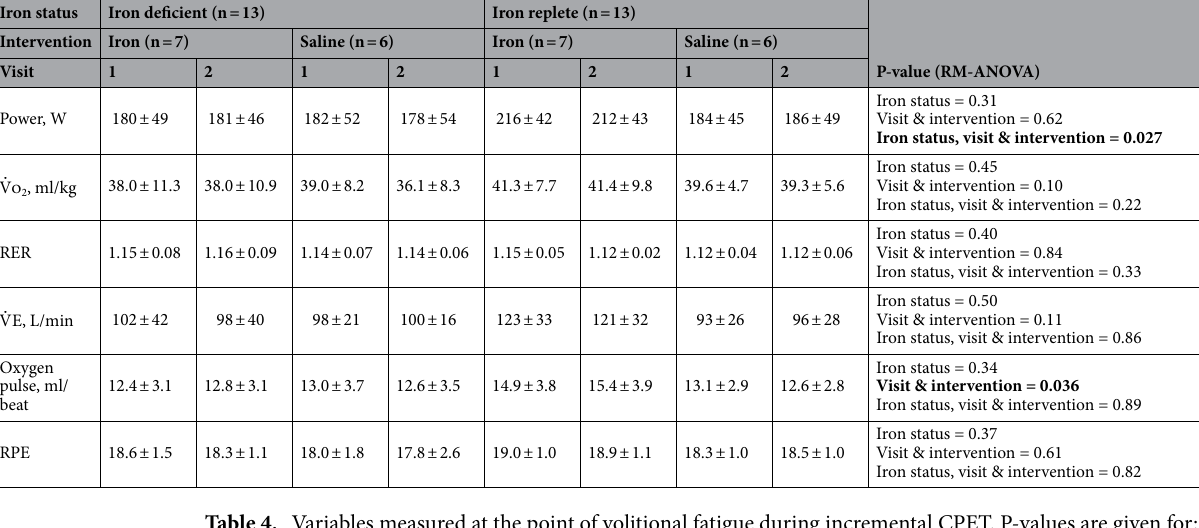
Table 4. Variables measured at the point of volitional fatigue during incremental CPET. P-values are given for: (i) the effect of baseline iron status; (ii) the interaction between visit and intervention (the effect of IV iron); and (iii) the interaction between baseline iron status, visit, and intervention (whether any effect of IV iron differed according to baseline iron status). Values are means ± SD. Statistically significant P-values appear in ˙ V ˙ V bold. RER, respiratory exchange ratio; E, minute ventilation; oxygen pulse is defined as o 2 divided by heart rate; RPE, rating of perceived exertion.